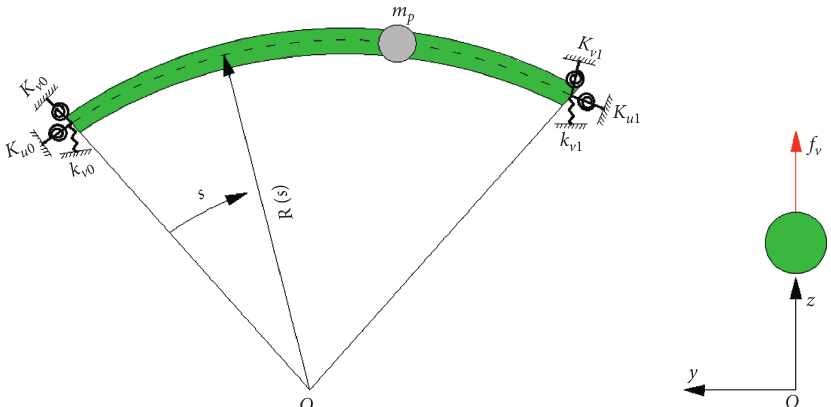
Figure 3: Out-of-plane vibration model of a curved beam supported elastically at both